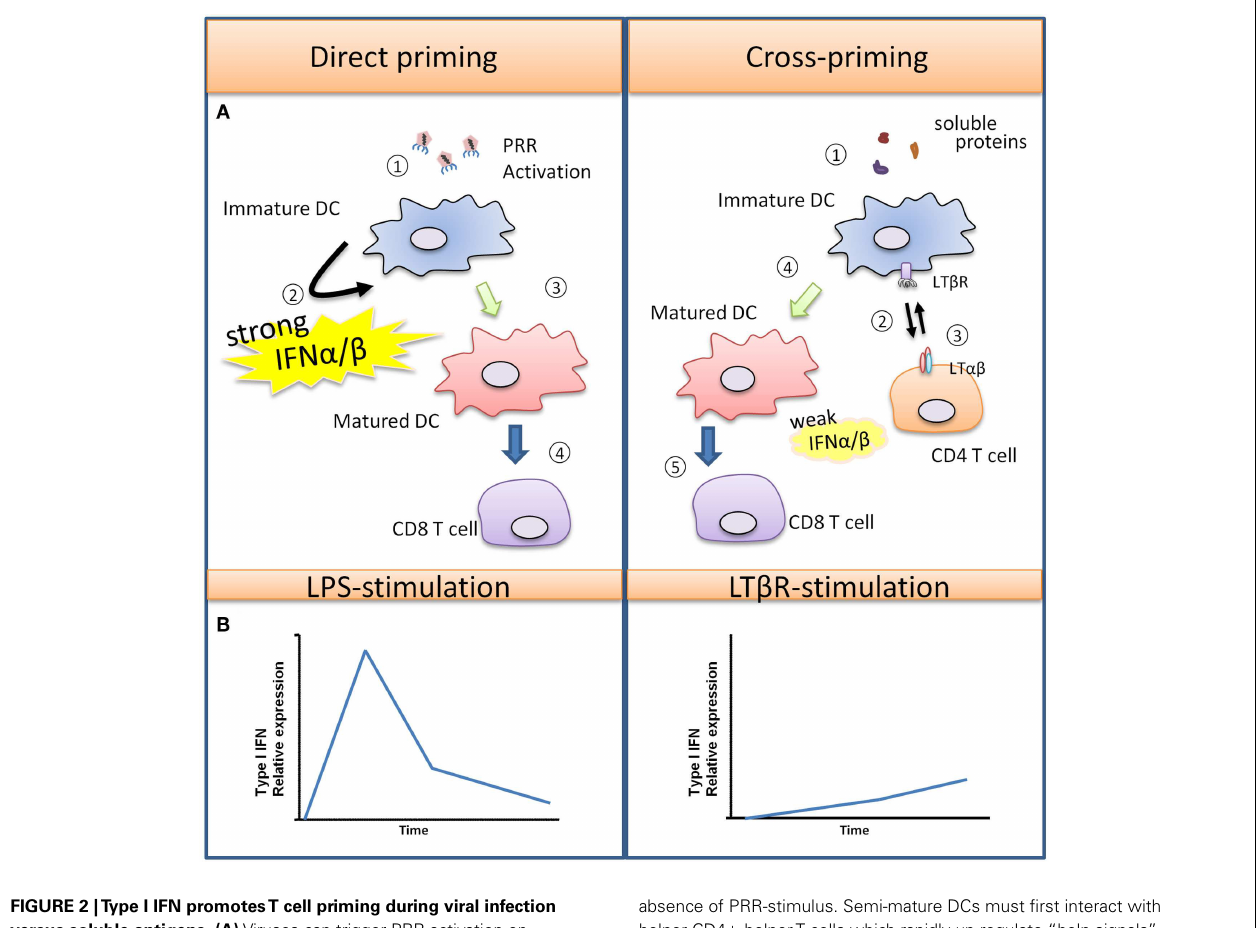
FIGURE 2 |Type I IFN promotesT cell priming during viral infection versus soluble antigens . (A) Viruses can trigger PRR activation on immature DCs, leading to DC maturation and production of various pro-inflammatory cytokines and a large quantity ofType I IFN. In this scenario, DCs are strongly activated, and they are capable of directly interacting with CD8 + T cells for the generation of virus-specific CTLs. In the case of soluble antigens, DCs are poorly activated due to the